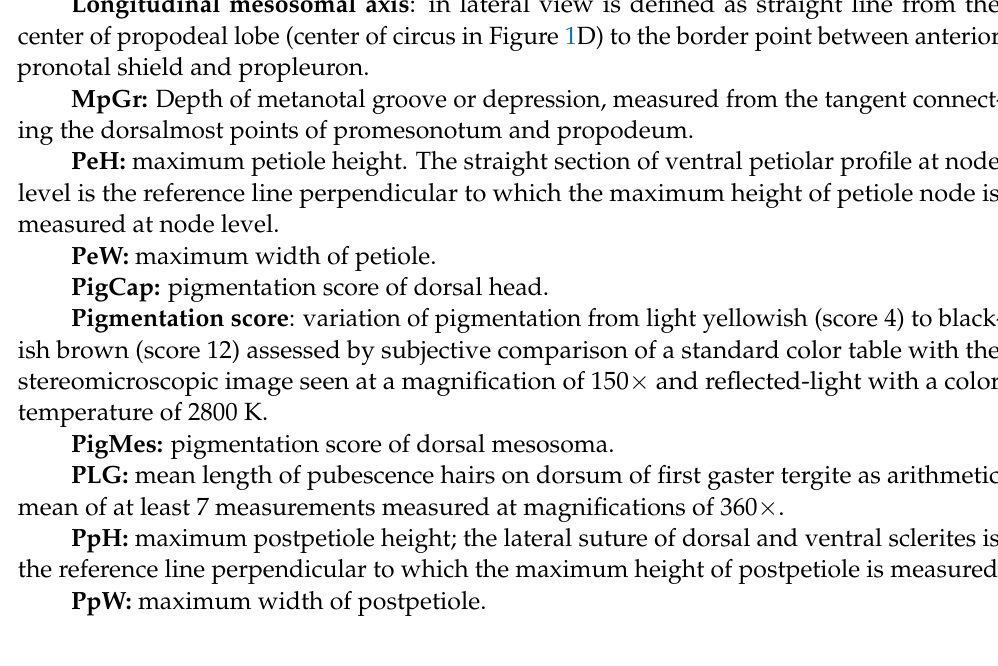
pronotal shield and